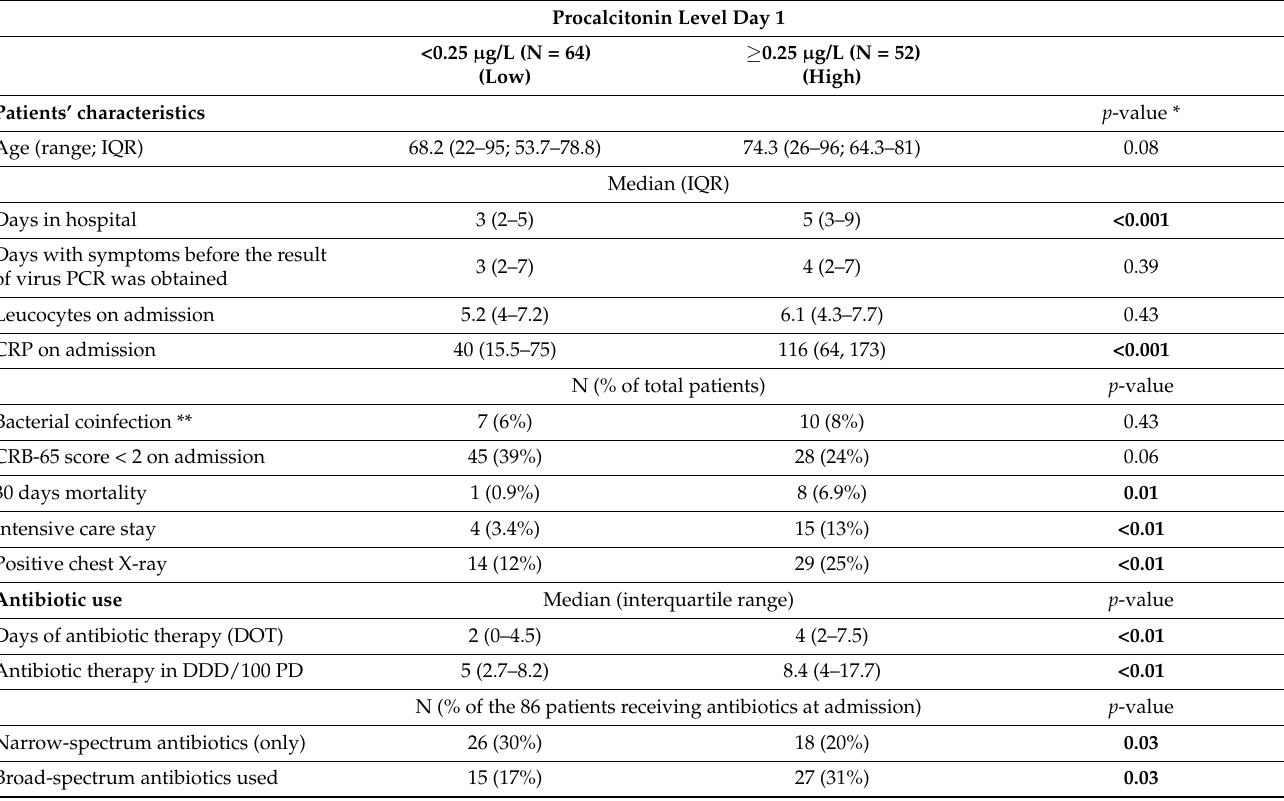
Table 3. Comparison of low and high PCT